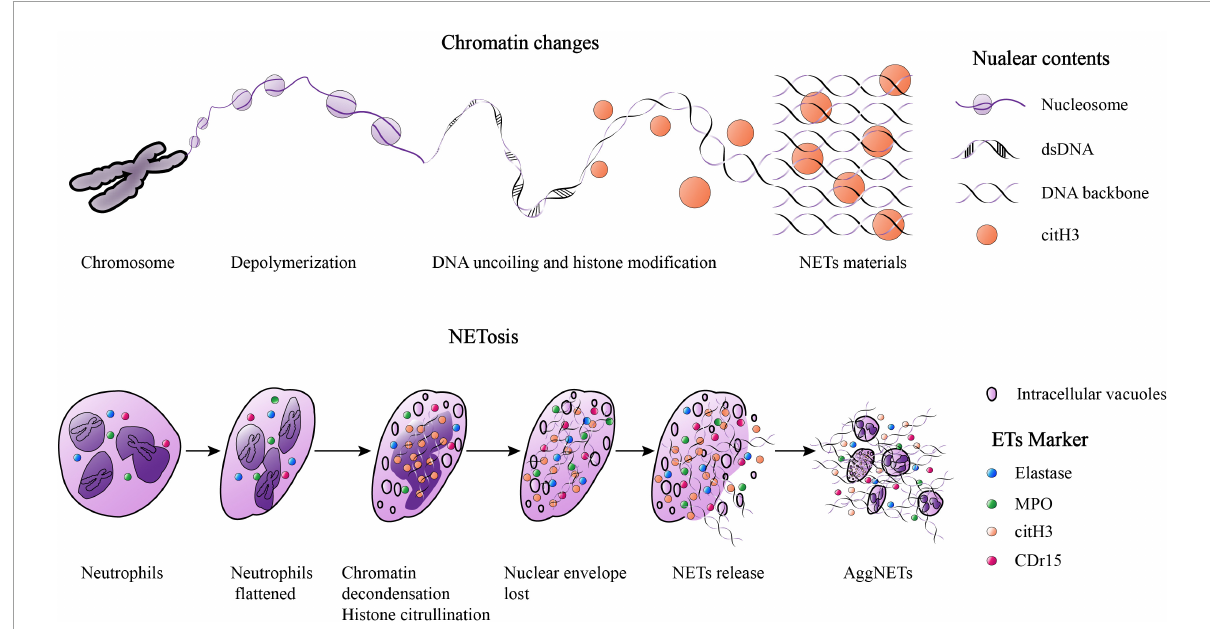
FIGURE1 The Chromatin changes when NETosis and the process of NETosis. When “NETosis” occur, the chromosomes in nuclear will experience the following phases: chromatin depolymerization, DNA uncoiling and histone modification, finally forming net-like structures. The NETosis process include: isolated neutrophils flattened, the formation of intracellular vacuoles, chromatin decondensation, histone citrullination, the loss of the nuclear envelope, the mixing of cytoplasmic granular proteins and nuclear contents, membrane integrity destroyed, and ultimately, NETs were released. A large amount of NETs gathered and formed the